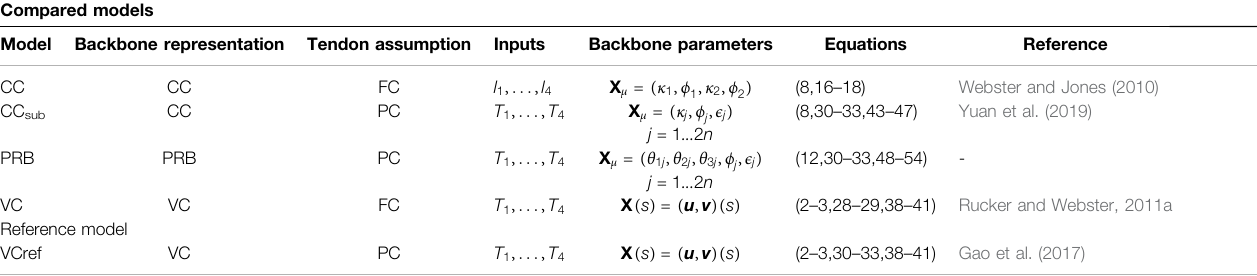
TABLE 2 | Models of TDCR used in the case study. Backbone representations CC: Constant curvature, CC sub : Constant curvature assumption applied to each sub segment, PRB: Pseudo rigid body, VC: Variable curvature. Tendon assumptions FC: Fully constrained, PC: Partially constrained. Compared